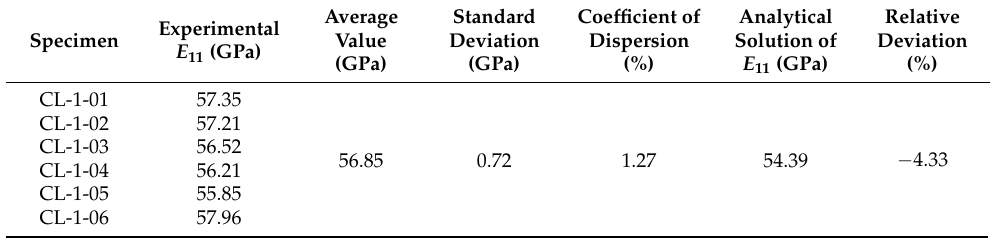
Figure 12. Tensile specimens of the T300/Cycom970 fabric laminates. Table 6. Experimental uniaxial tensile modulus of the T300/Cycom970 fabric laminates and compari- son with the analytical